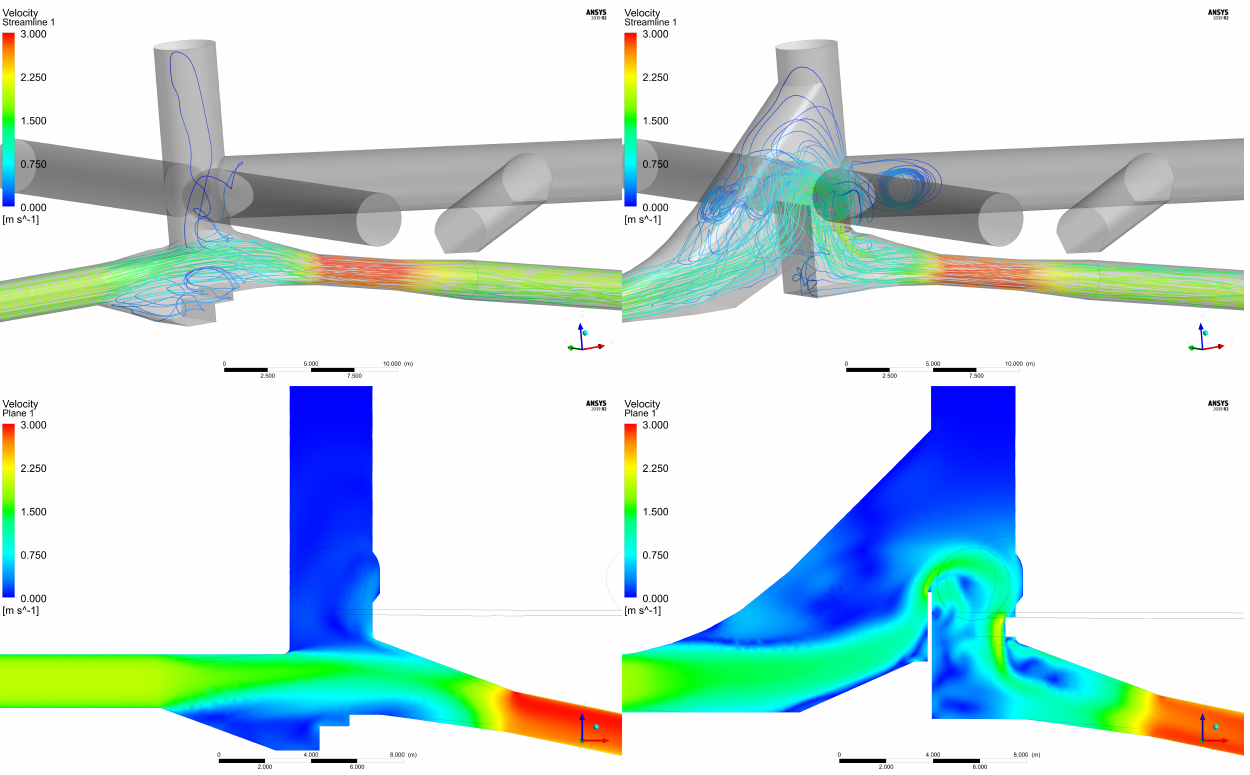
Figure 5. Numerical results for a constant discharge of 7.079 m 3 /s—comparison of the original geometry of the surge tank (left column) with the new approach including the wall and extra excavation (right)—streamlines (upper row) and cross section at the xz -plane (lower